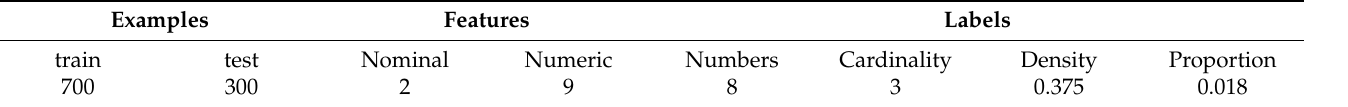
Table 4. Original dataset